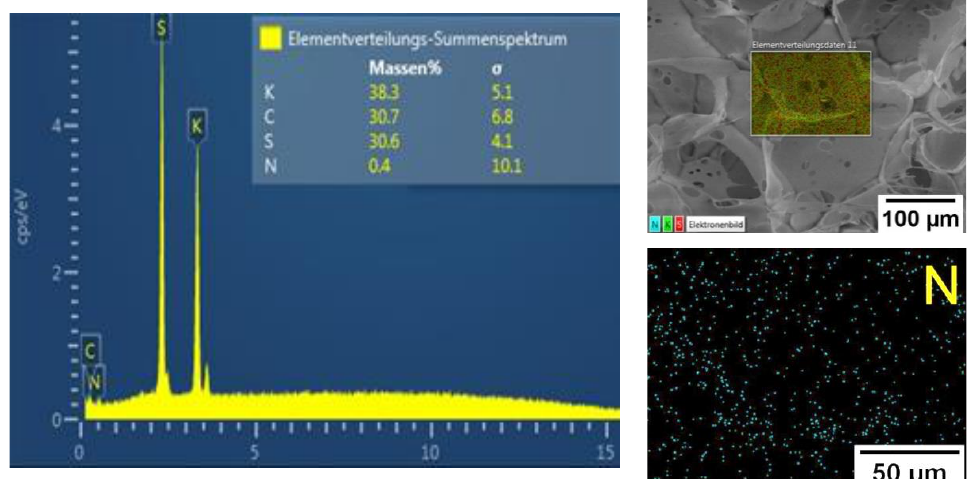
Figure 3. EDX analysis data for the P(SPM-VA) cryogel.